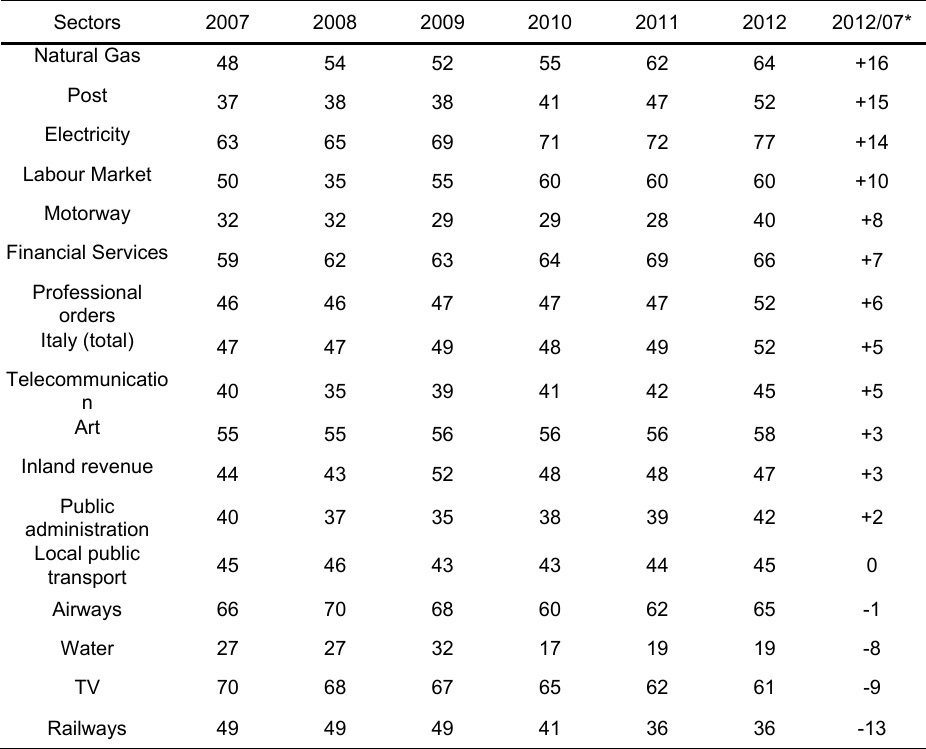
Table 1: Index of Liberalisation (Italy) Sectors